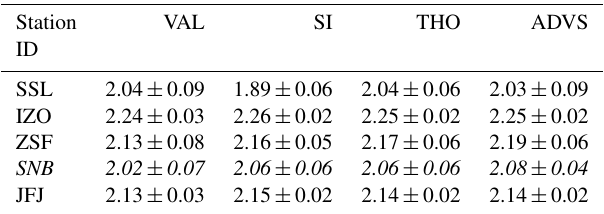
Table 3. Mean annual growth rates (ppmyr − 1 ) with 95% confi- dence intervals from linear regression, applied on the trend com- ponents by STL over 2010 to 2015, except for SNB. Data at SNB were decomposed over 2012 to 2015 due to missing data from 2010 to 2011 and thus shown in italic